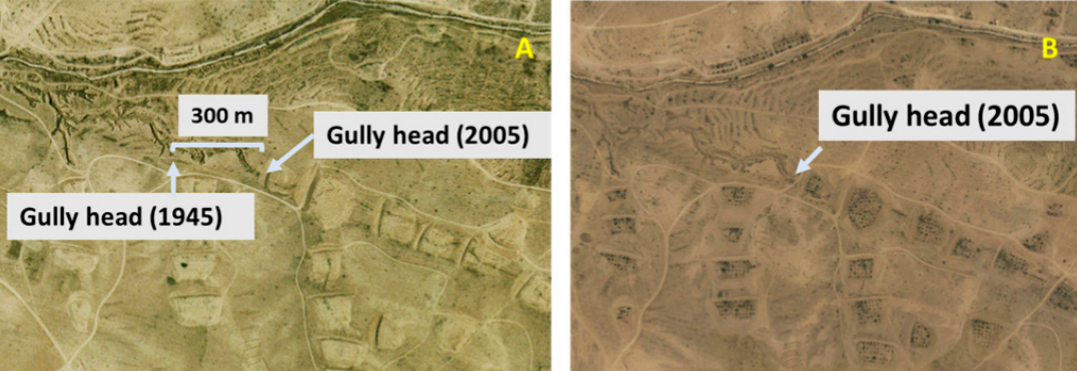
Figure 3. Aerial photos showing soil erosion processes in a secondary channel of Wadi Karkur (Northern Negev) indicating perennial damage to the channel system. ( A ). Increasing gully head channel from 1945 to 2005, 300-m regression in the channel that occurred in a period of 60 years (degradation without management); ( B ). The results of management activities, constructing of human-made sinks (Source: Survey of Israel, ( A ) at 2007; ( B ) at 2010).